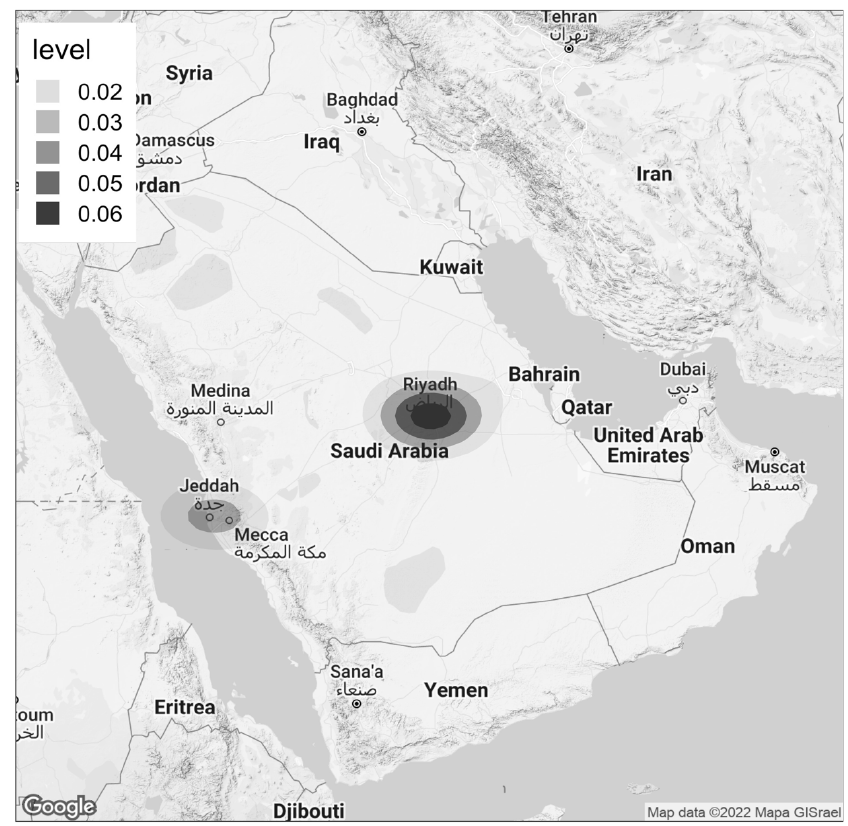
Figure 2. Density of individuals with high ARABRISK score (≥33) using geospatial mapping tech- nique by geolocating IP addresses. Other variables significantly associated with high ARABRISK scores in the univaria- ble model were being married (OR = 6.27, 95% CI = 4.75 to 8.26, p < 0.001), divorced or widowed (OR = 6.81, 95% CI = 4.11 to 11.29, p < 0.001), or retired (OR = 6.32, 95% CI = 4.20 to 9.50, p < 0.001), all of which maintained their statistical significance in the multivariable model. By contrast, the same model revealed that lower ARABRISK scores were associ- ated with having private insurance (OR = 0.67, 95% CI = 0.50 to 0.88, p = 0.005) and being unemployed (OR = 0.63, 95% CI = 0.48 to 0.82, p < 0.001). 4. Discussion In our web-based, cross-sectional national survey study, we aimed to study the risk of developing T2DM among adult Saudi nationals without diabetes using the ARABRISK questionnaire. In the process, we also investigated the degree to which sociodemographic variables affected the identified level of risk. We believe that the outcomes of our study can be a useful basis for a larger study in the future. In our study, the prevalence of individuals with high risk of developing T2DM, 7.5%, was less than in previous studies [5,18,19]. The differences could be explained by our mostly younger sample, 88.1% of whom were 18 to 39 years old. The most reported risk factors were a family history of diabetes (81.1%), an inadequate daily intake of fruits and vegetables (71.1%), a lack of exercise (57.9%), and BM I ≥ 2 5 (51.4%). Residing in a large city, not having private insurance, being retired, and being married, divorced, or wid- owed were the sociodemographic variables that most predicted high ARABRISK scores.